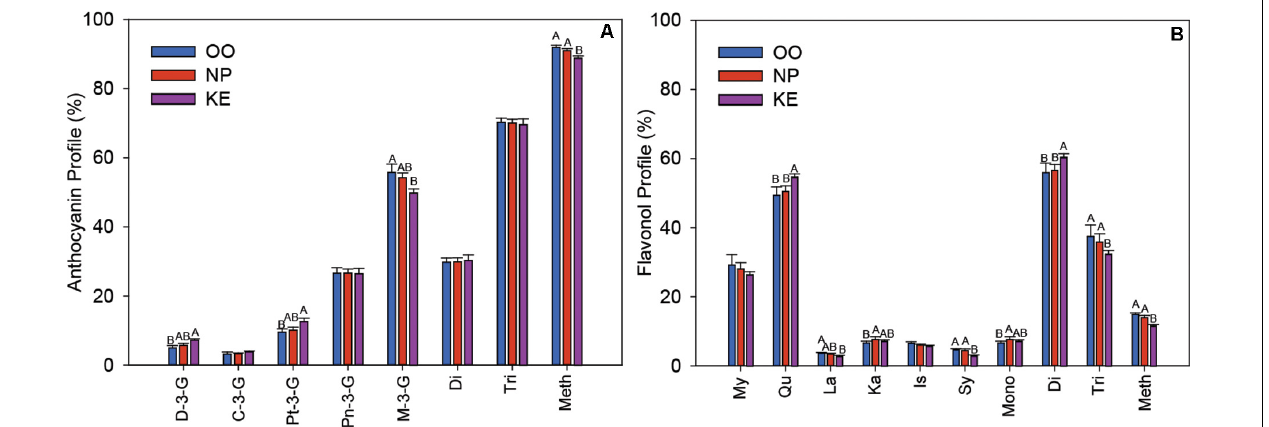
FIGURE 7 | Relative abundance of individual anthocyanins and anthocyanin fractions (A) and individual flavonols and flavonol fractions (B) in the three sub-regions of the OV (OO, blue; NP, red; and KE, purple). C, cyanidin; Pn, peonidin; D, delphinidin; Pt, petunidin; M, malvidin; Di, di-substituted; Tri, tri-substituted; Meth, methoxylated for anthocyanins (A) ; and My, myricetin; Qu, quercetin; La, laricitrin; Ka, kaempferol; Is, isorhamnetin; Sy, syringetin; Mono, mono-substituted; Di, di-substituted; Tri, tri-substituted; Meth, methoxylated for flavonols (B) . Error bars indicate standard error within each sub-region. An ANOVA was performed to test the effect of the sub-regions with vineyards considered as nested factors within sub-regions. Different letters indicate significant differences ( p < 0.05) between sub-regions according to a Tukey’s HSD